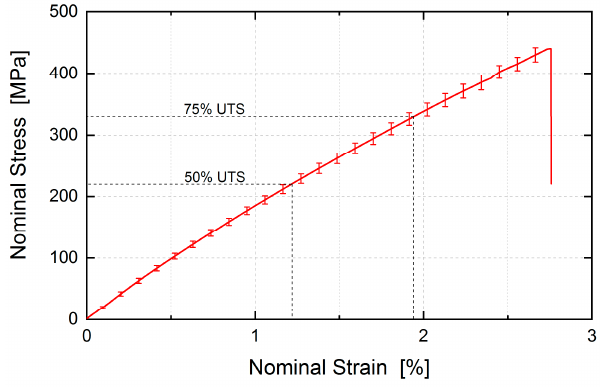
Figure 2. Stress-strain behavior of the quai-isotropic BFRP laminate. The vertical error bars represent the standard deviation of the individual tests over the test series [26]. The UTS is 441±33 MPa. CT scans for subsequent examination with DVC were performed at two different loading states corresponding to 50%, and 75%